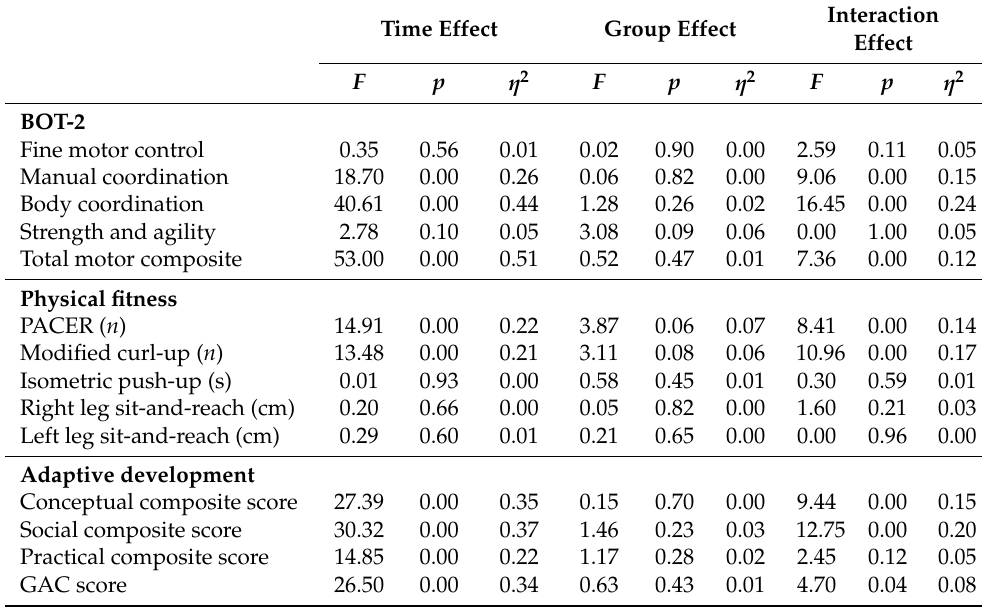
Table 4. Results from two-way ANOVA with repeated measures on one factor (time).